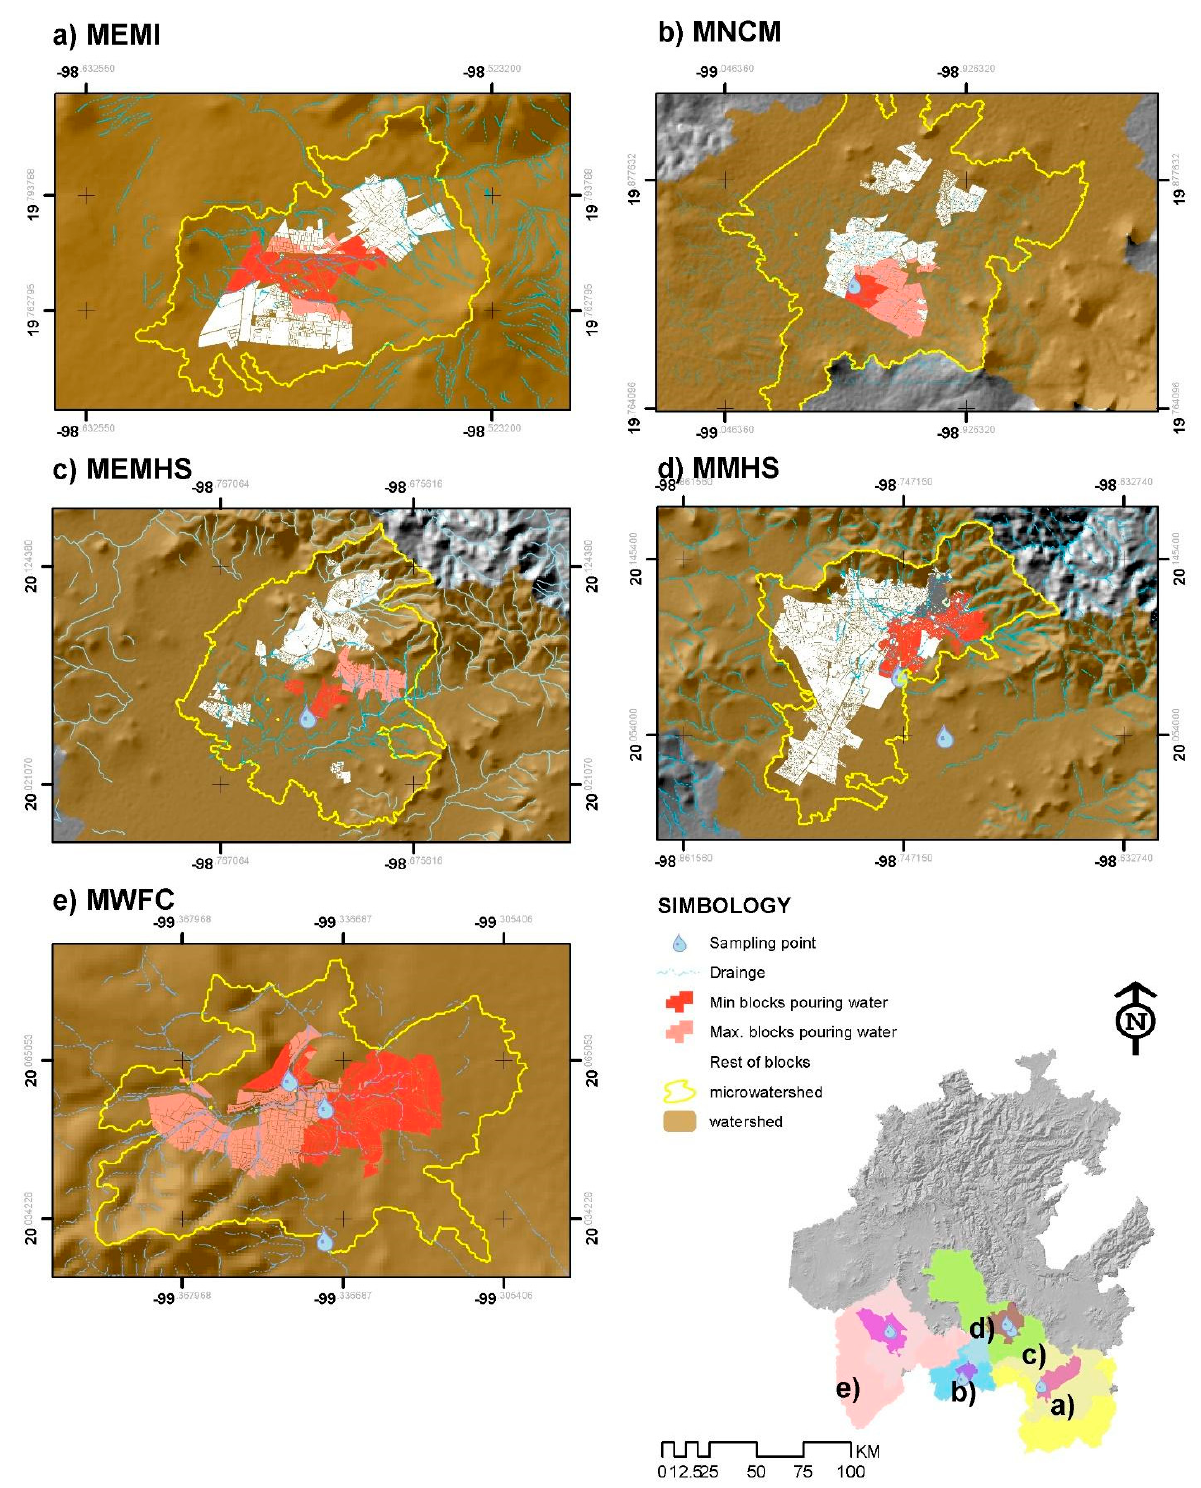
Figure 2. Geographic definition of the micro-basins and sampling sites of five municipalities of the State.